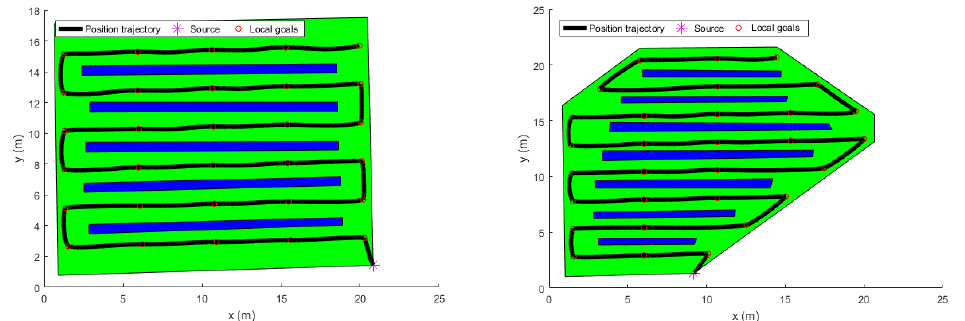
Figure 10. The generated optimal trajectories (2D